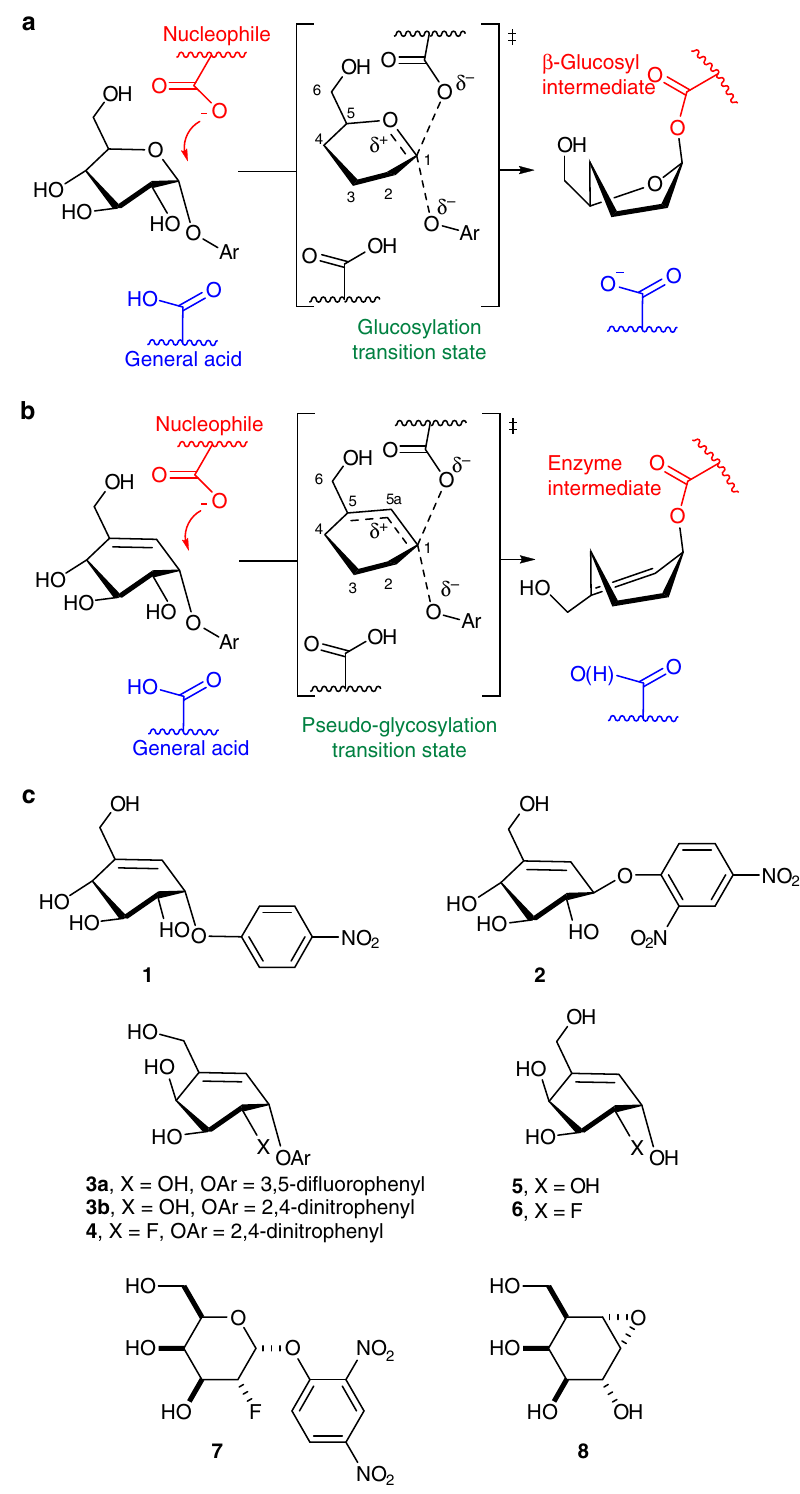
Fig. 2 Glycoside hydrolase catalysis and chemical structures for select inhibitors. a Mechanism for glucosylation with a natural substrate analog. b Proposed mechanism of pseudo-glucosylation for the allylic α -glucoside mimic 1 . c Structures of mechanism-based 4-nitrophenyl covalent inhibitor 1 ; 2,4-dinitrophenyl β -glucoside analog 2 ; the α -galactose analog inhibitors 3a , b ; the 2-deoxy-2- fl uoro covalent inhibitors 4 ; 5 , and 6 the hydrolyzed products for the α -galactose analog inhibitors 3 and 4 , respectively; and two conventional glycoside hydrolase inactivators: 2-deoxy-2- fl uorogalactoside ( 7 ) and cyclophellitol analog ( 8 ). For clarity, most hydroxyl groups are not shown for the transition state or intermediate in a ,